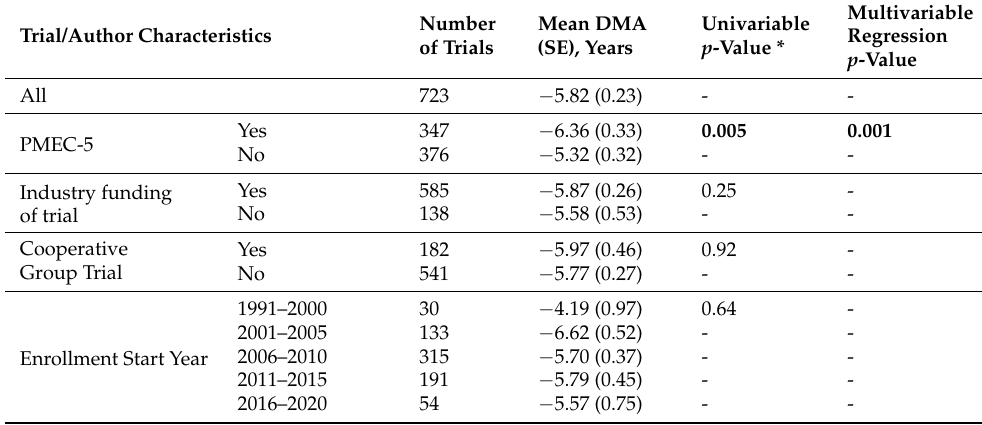
Table 2. Factors associated with age